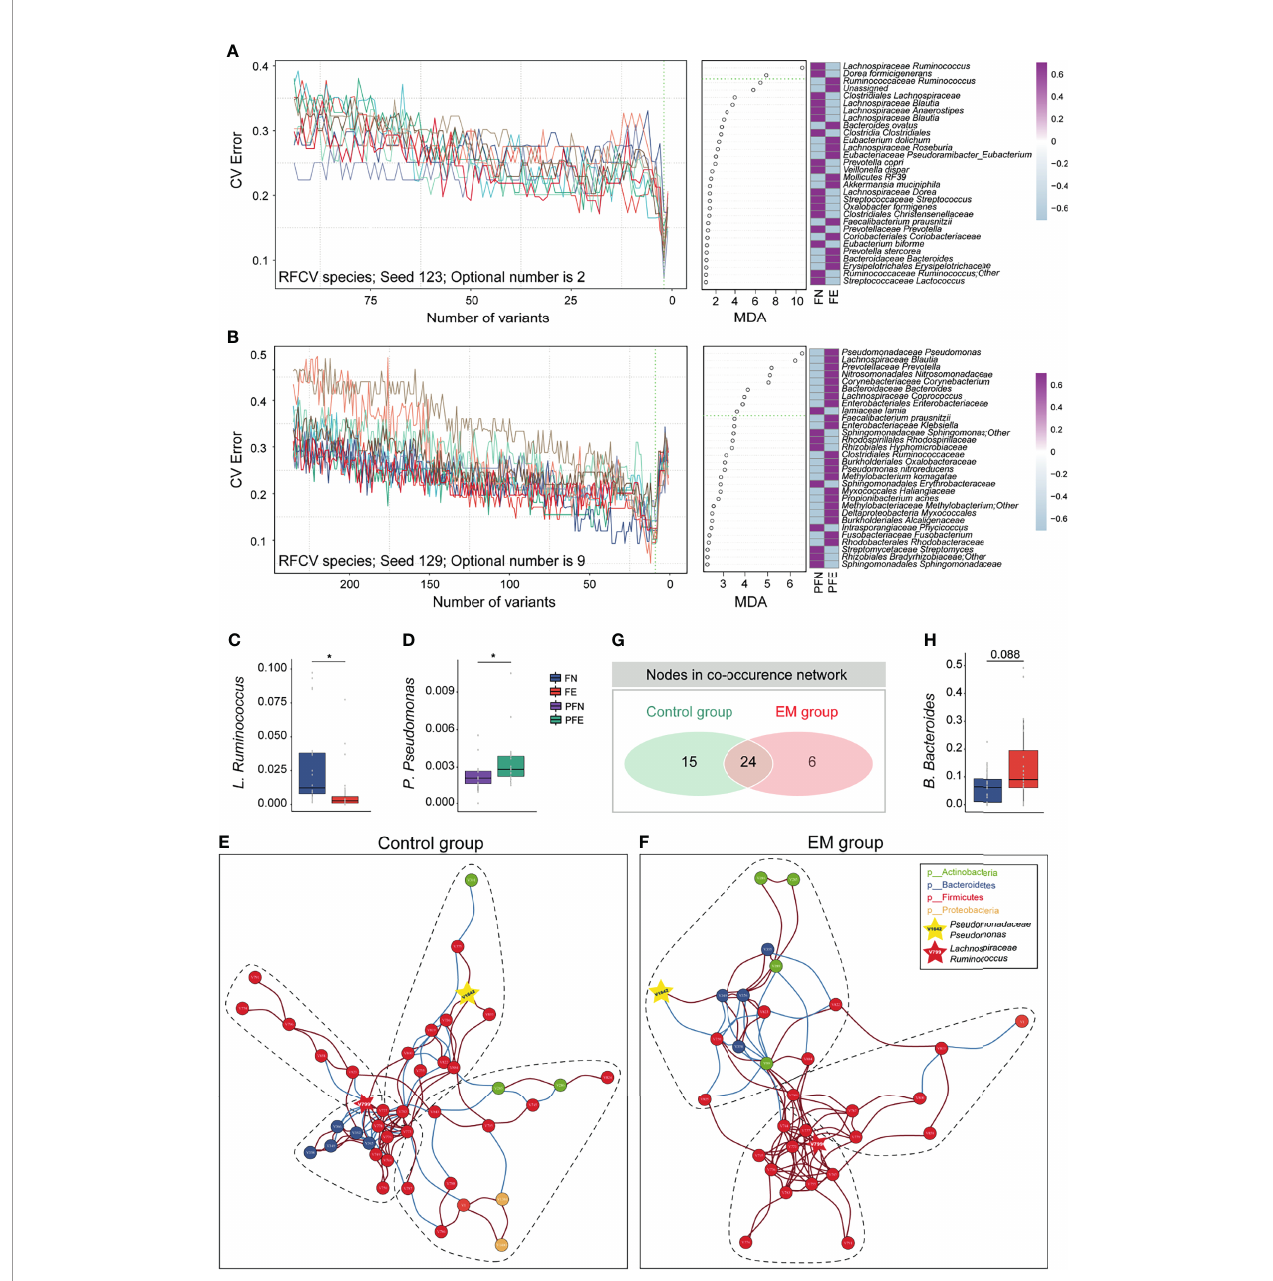
FIGURE 4 | Ecological relationships between microbiota within different habitats. (A) Random forest and fi ve-fold cross validation (RFCV) models to predict fecal biomarker in EM. (B) RFCV models to predict biomarker in peritoneal cavity. (C, D) Box plots illustrated the relative abundance of Lachnospiraceae Ruminococcus and Pseudomonadaceae Pseudomonas between groups. (E, F) The co-occurrence networks depicting commensal correlation of gut bacteria and P. Pseudomonas of control and EM, respectively. Nodes are colored by which phylum it belongs to. Based on Spearman correlation coef fi cients, the edges between each pair of nodes are colored by red (positive correlation, p < 0.05) or blue (negative correlation, p < 0.05). (G) Venn diagram shows the number of overlap nodes. (H) Box plots illustrated the relative abundance of Bacteroidaceae Bacteroides between groups; box boundaries show quartile. The p value denotes Mann – Whitney U test. *p <